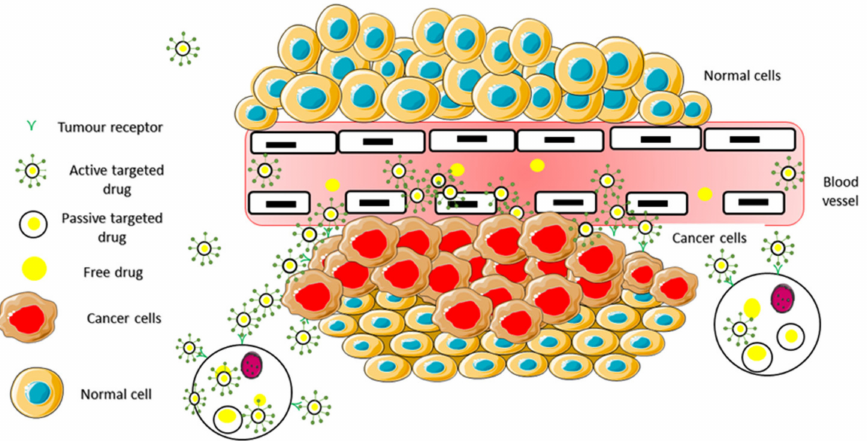
Figure 9. Active binding of the ligand attached to the nanocarrier surface to receptors commonly overexpressed by the cancer cells.